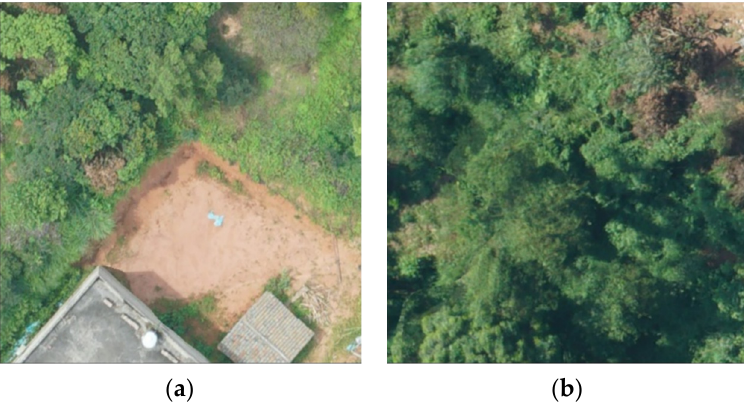
Figure 17. The picture of a diseased tree similar to a ground feature. ( a ) Figure 1; ( b ) Figure 2.